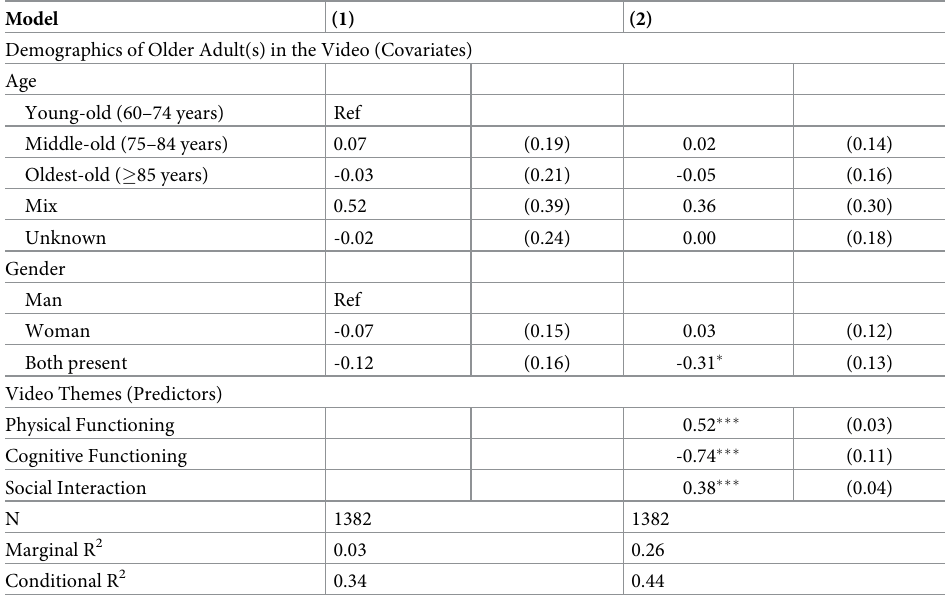
Table 2. Mixed-effects model predicting the valence of video content created by older adults on